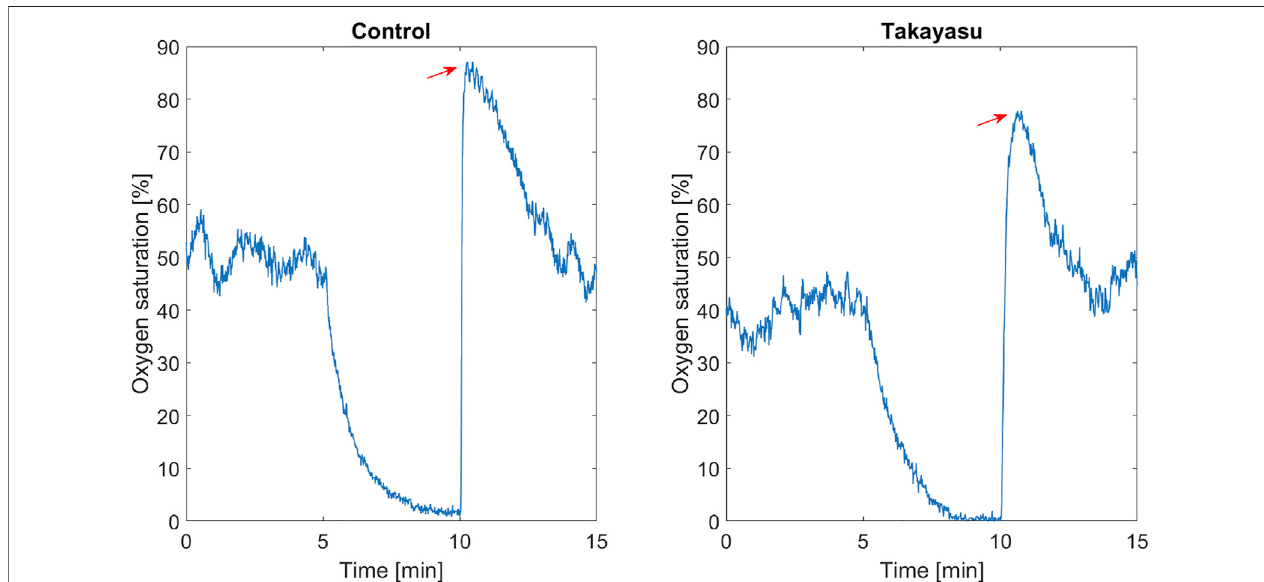
FIGURE 1 | Oxygen saturation (%), baseline, during arterial occlusion (between 5 and 10 min), and in the post-occlusive hyperemia phase, in one healthy control and in one Takayasu patients with subclavian stenosis. Red arrow marks oxygen saturation peak.